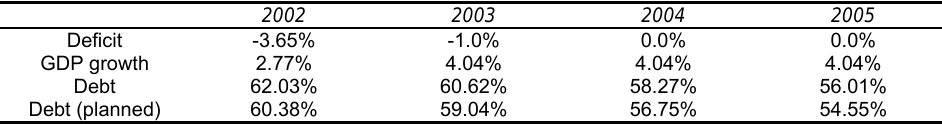
Table 3. German government deficit plan after a one-time deviation in